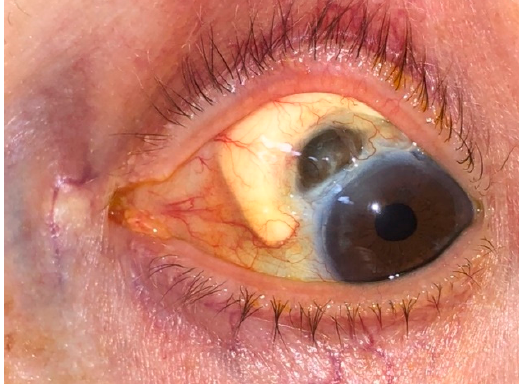
Figure 3. Scleromalacia perforans (treated with scleral